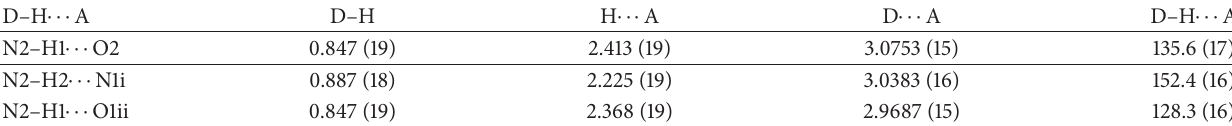
Table 2: Hydrogen bond geometry (˚A, ∘ ) of 5a .